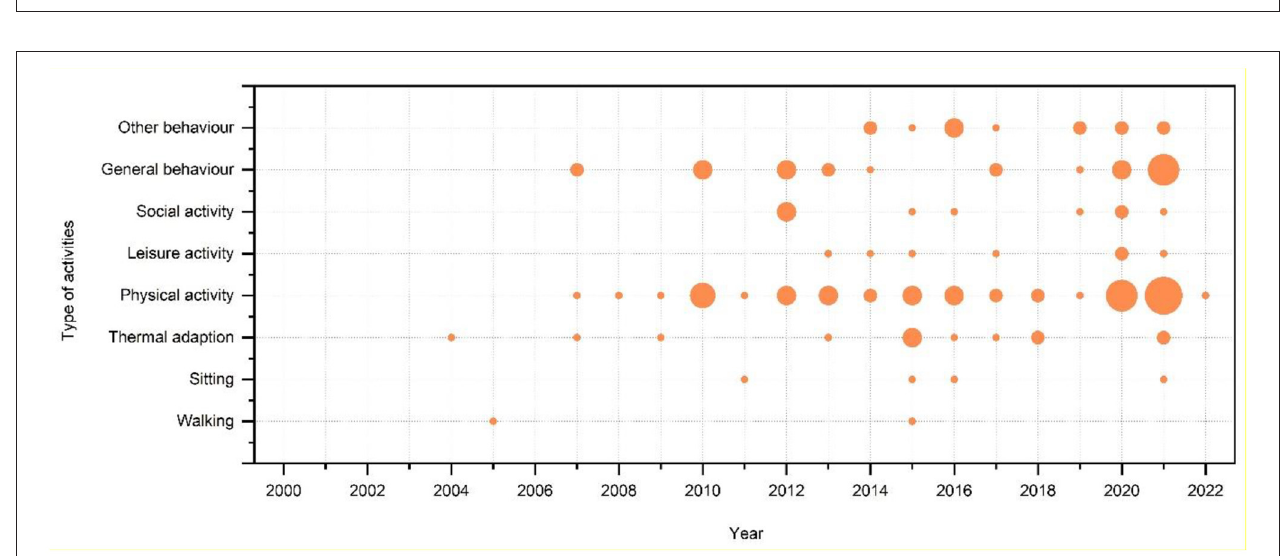
FIGURE 4 | Distribution of types of behaviors being studied or focused.